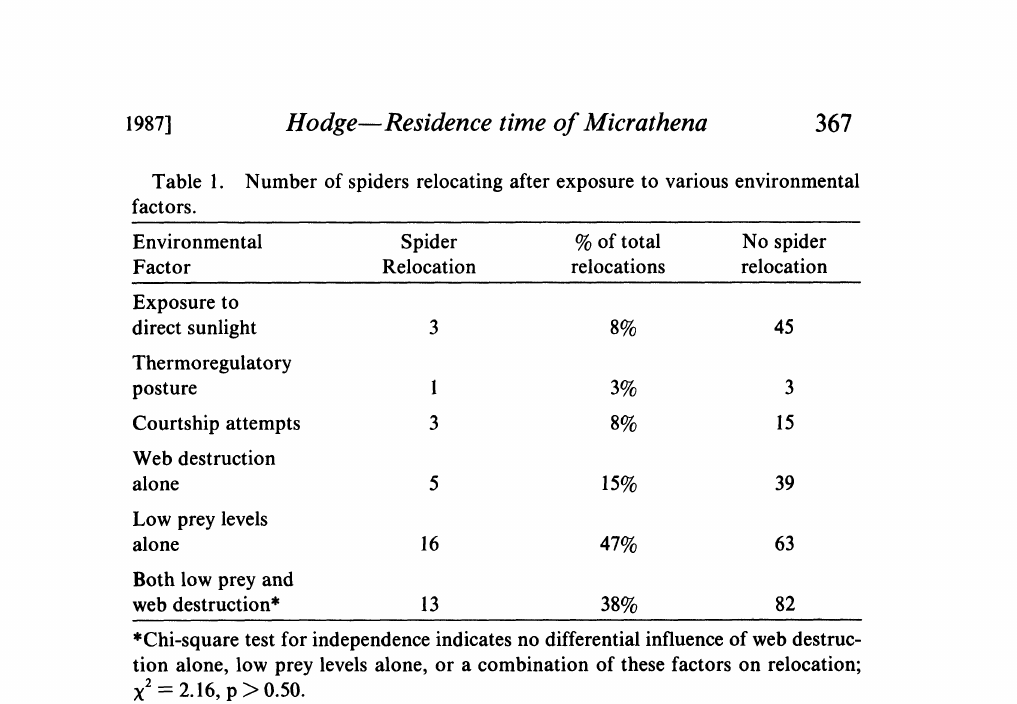
Table 1. Number of spiders relocating after exposure to various environmental